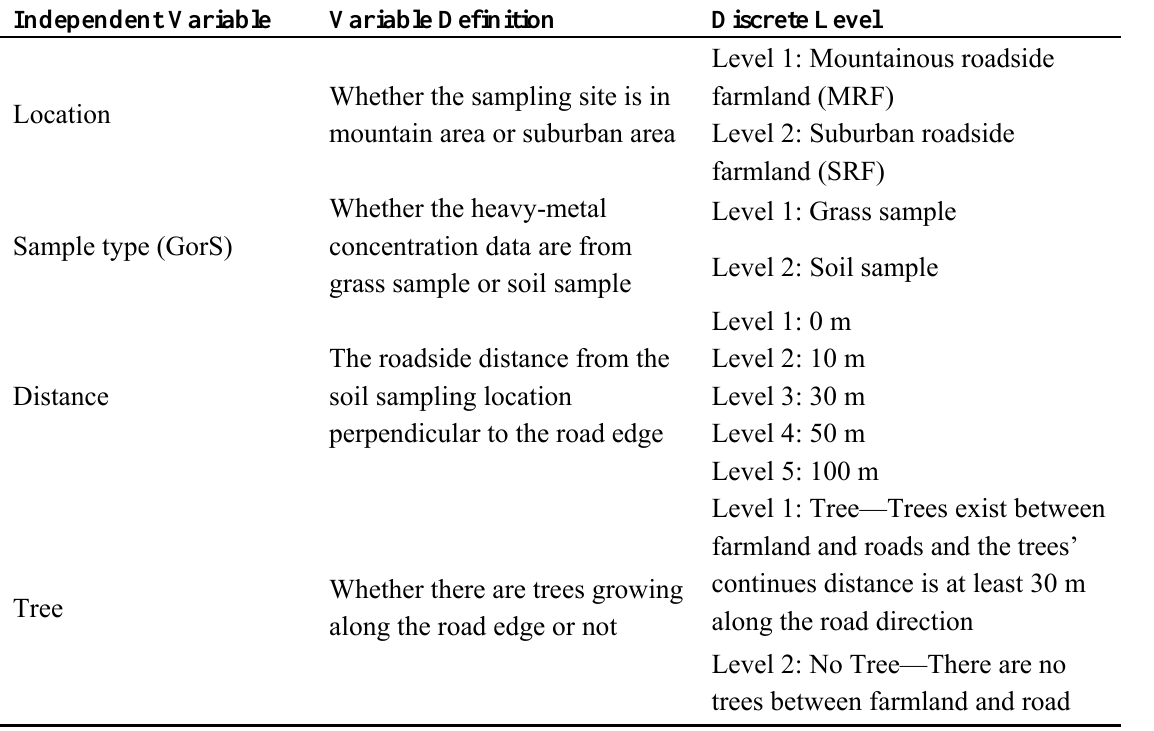
Table 1. Description of four independent variables for MANOVA.